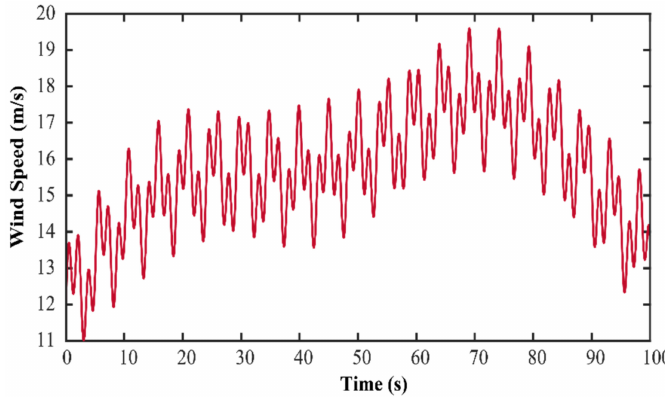
Figure 11. Wind speed profile.